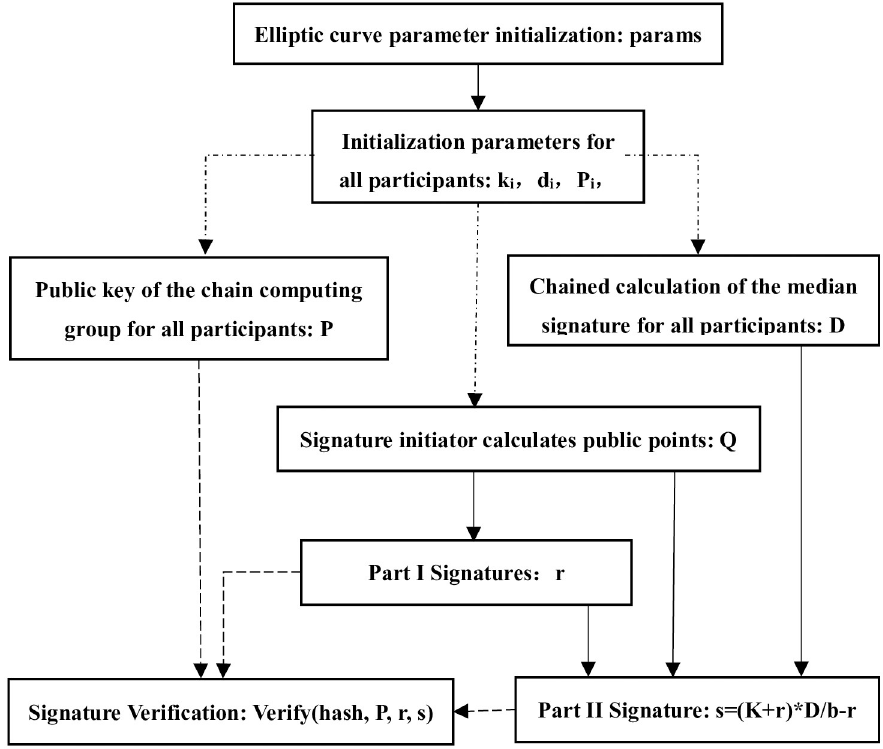
Fig 1. Multi-party co-signature flow